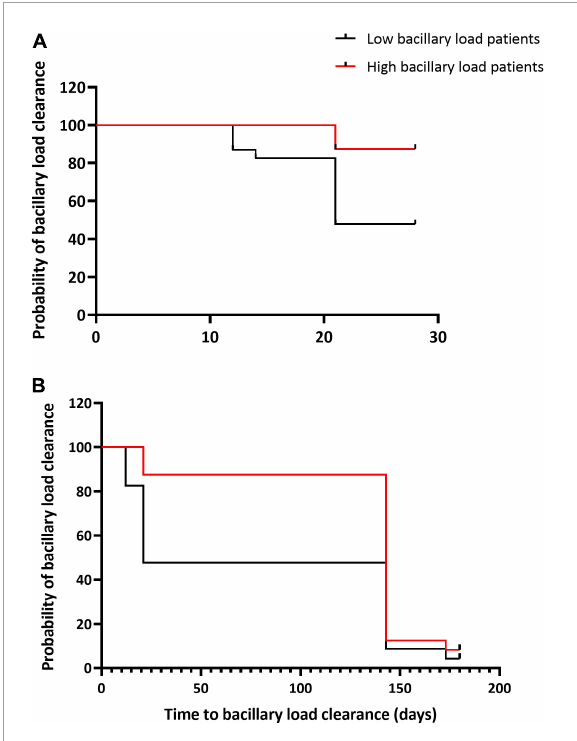
FIGURE4 Bacillary load clearance during treatment in relation to baseline bacterial loads. Kaplan–Meier curves show TB-MBLA bacillary load clearance by week 8 of treatment (A) and by the end of treatment week 26 (B) among patients with high and low baseline bacterial load. Low baseline bacterial load patients were more likely to clear bacillary load at week 8, HR 5.6, p = 0.003 and at week 26 of treatment, HR 3.2, p = 0.014 than high baseline bacterial load